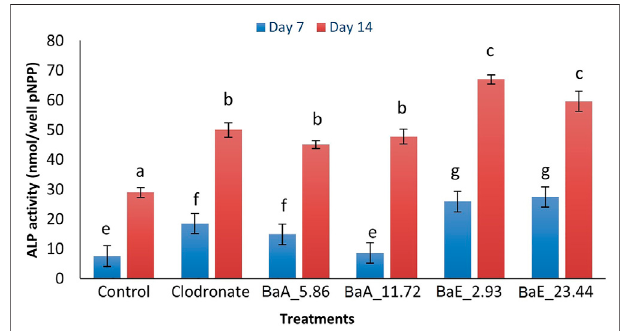
FIGURE 7 | ALP activity in B. acmella aqueous ( Ba A) and ethanol ( Ba E) extracts. Control (untreated cells), Positive control (Clodronate), BaE_2.93 ( Ba E at 2.93 µg/ml), BaE_23.44 ( Ba E at 23.44 µg/ml), BaA_5.86 ( Ba A at 5.86 µg/ml) and BaA_11.72 ( Ba A at 11.72 µg/ml). Different alphabets shows signi fi cant different ( p < 0.05) between treatments in a same day. The data are presented as mean ± SEM ( n (cid:2) 6).